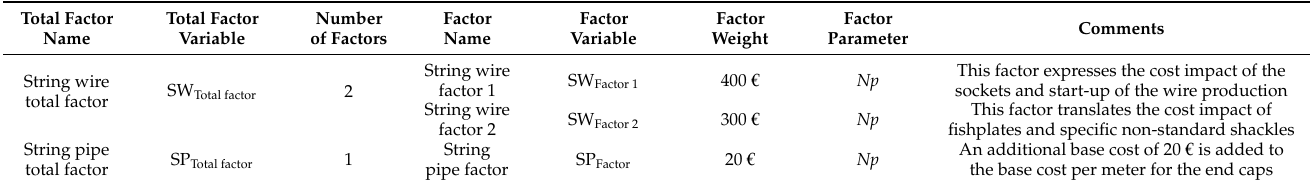
Table 5. String’s sub-elements’ base cost and